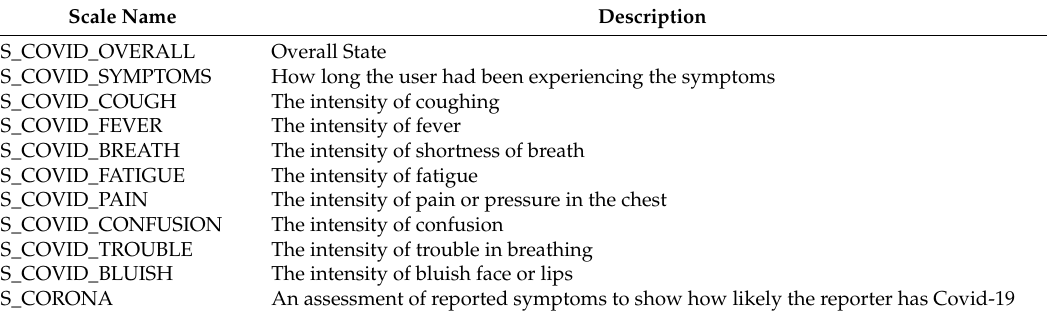
Table 1. The scales used by the participants to quantify their SARS-Cov-2